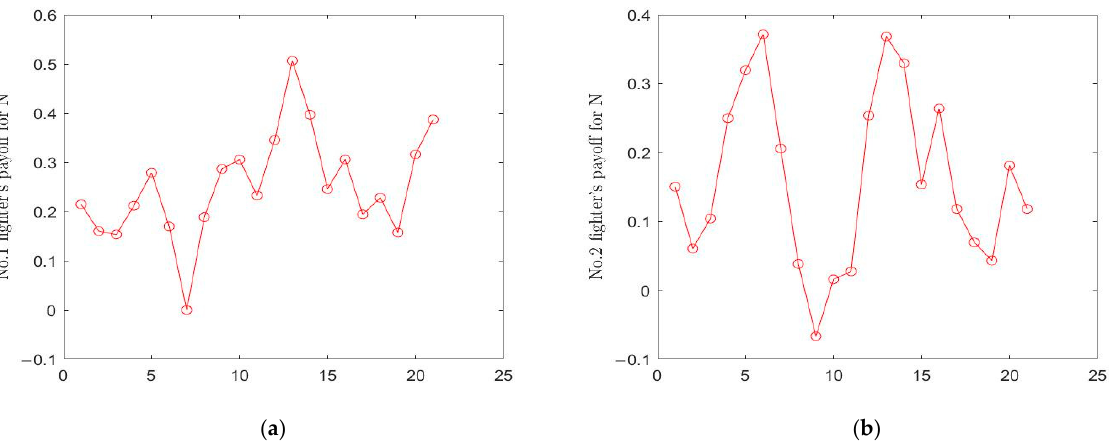
Figure 6. The payoff function change curves of the N side in the second layer decision. ( a ) No.1 fighter’s payoff for N; ( b ) No.2 fighter’s payoff for N.